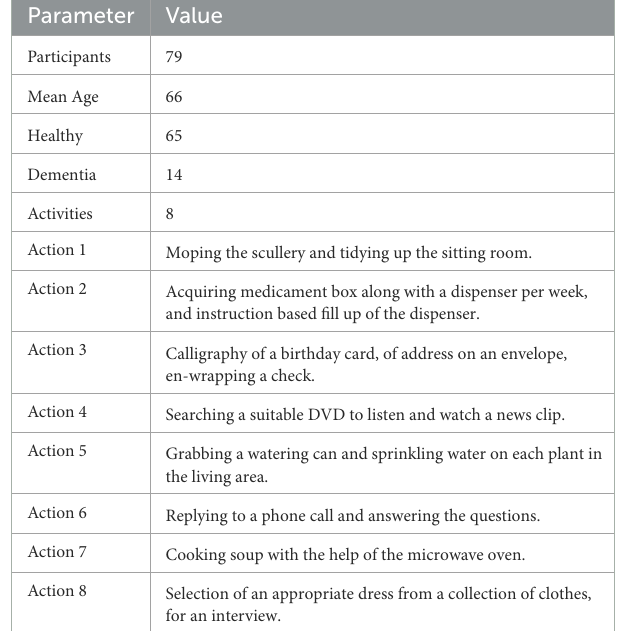
TABLE 1 Characteristics of the